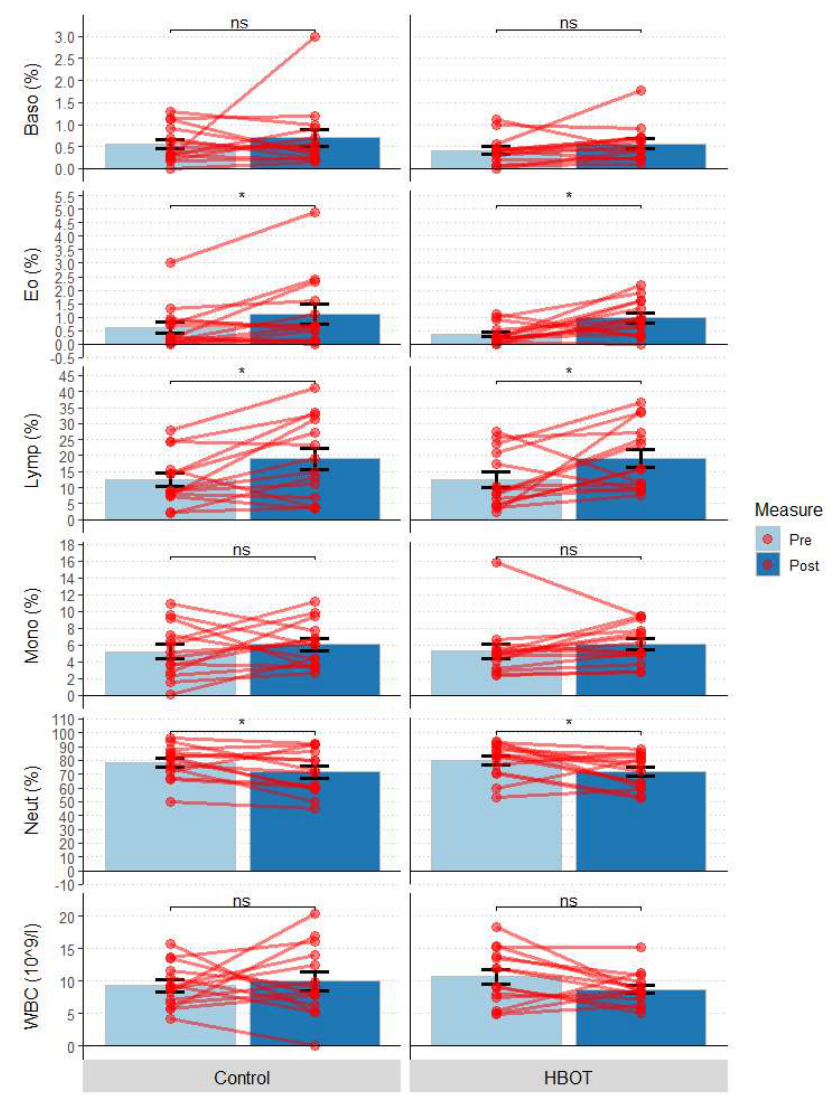
Figure 5. Change in leukocyte levels and leukocyte fraction at the first measurement (Pre) and 10 days after study initiation (Post); bars represent mean, error bars represent standard error, red lines represent individual patient results; * p < 0.05, ns p > 0.05; HBOT n = 14, Control n = 14.